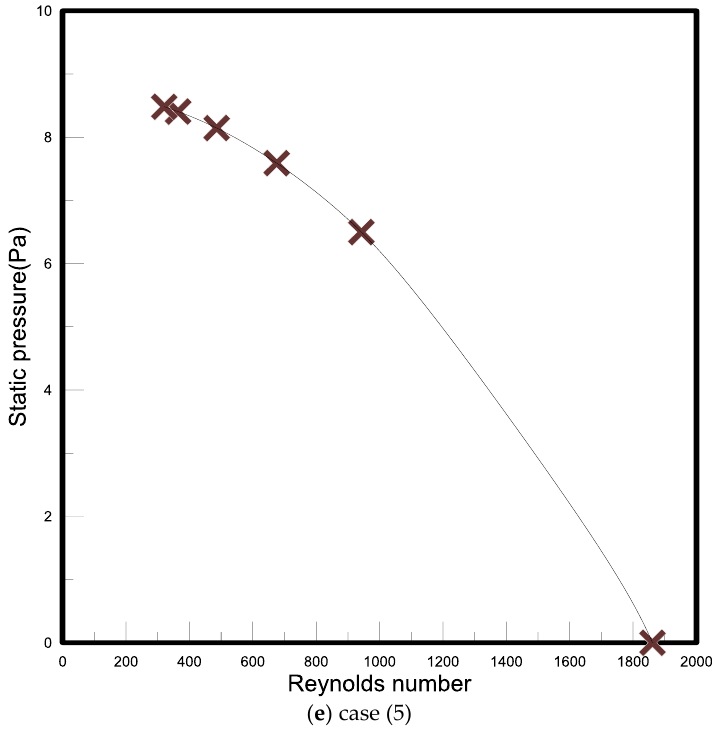
Figure 12. Each device of Reynolds number.